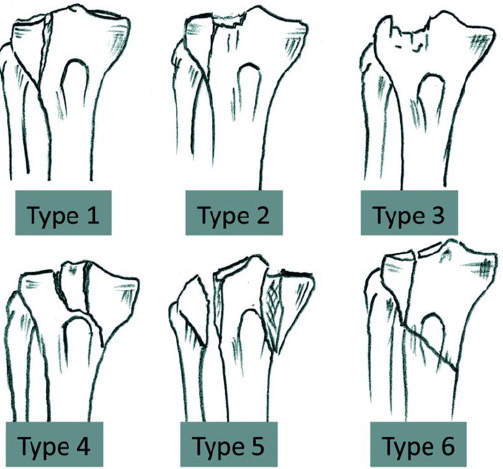
Figure 2. Schatzker classification for tibial plateau fractures [2].